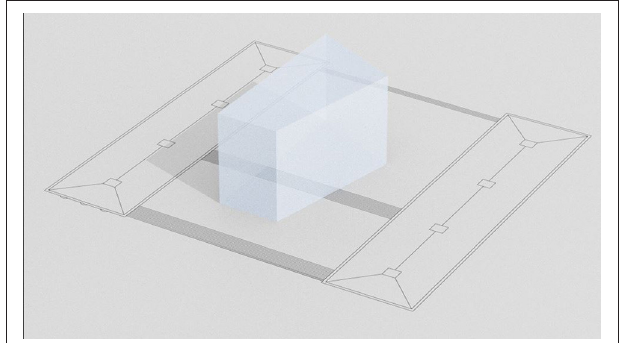
FIGURE 5 | The initial massing volume on site.